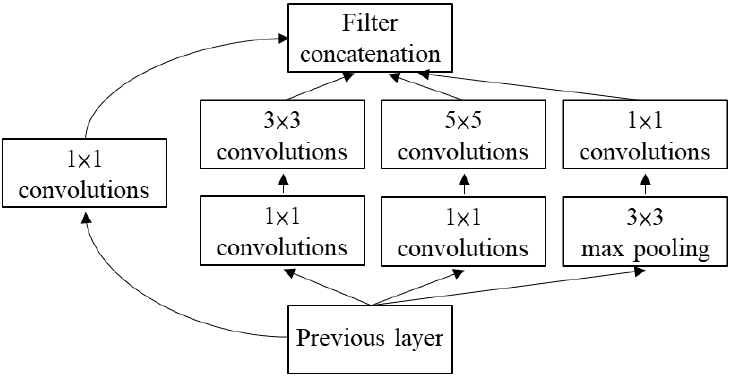
Figure 3. Google Net Inception Module.